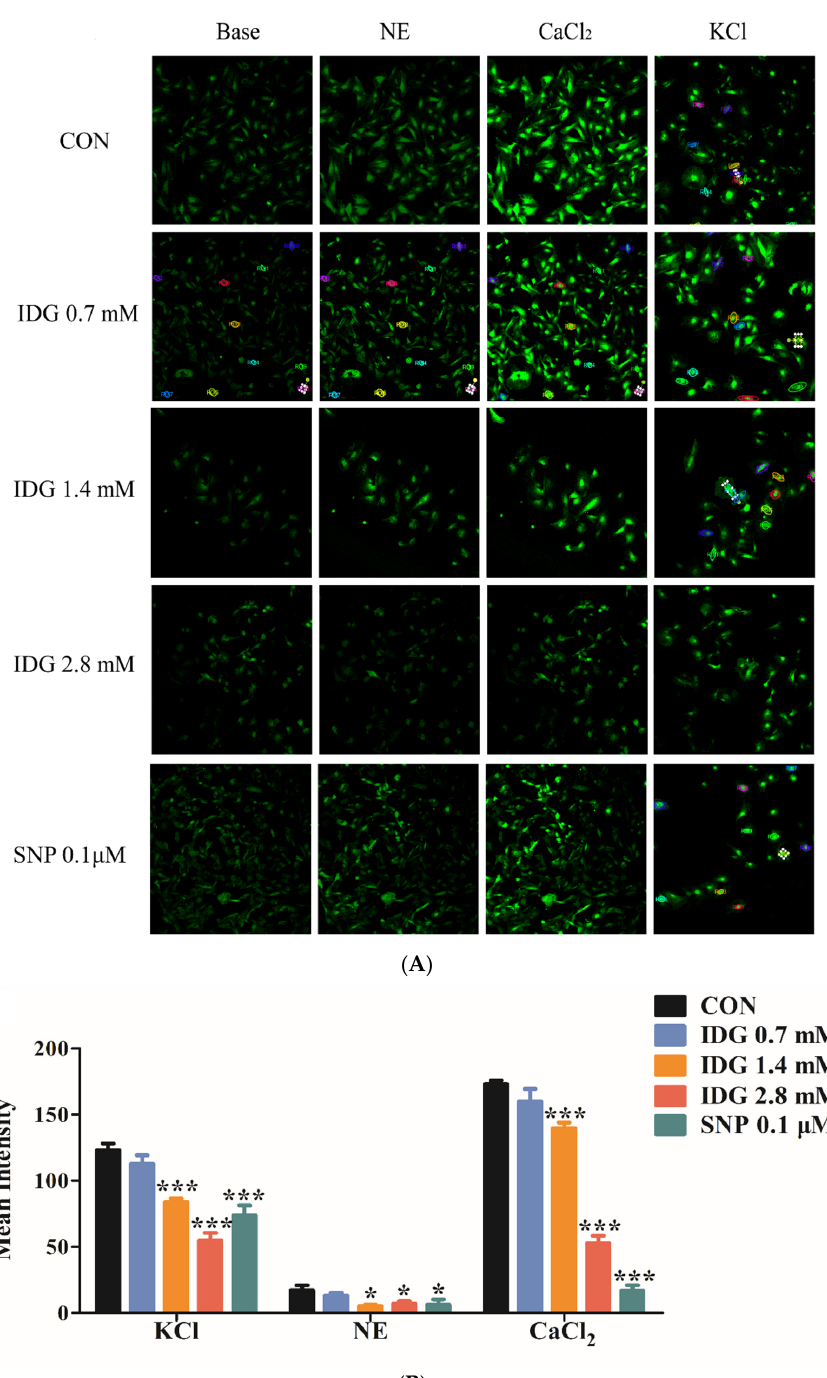
Figure 8. Relaxant effect of IDG (0.7, 1.4, and 2.8 mM) on vascular smooth muscle cells (VSMCs) contracted with NE (10 μ M) or KCl (100 mM). ( A ) The change in fluorescence intensities represent the change in [Ca 2+ ] in levels. Original fluorescence images (40×). ( B ) The effects of IDG (0.7, 1.4, and 2.8 mM) reduced the increase in intracellular fluorescence intensity in VSMCs due to KCl (100 mM) in Krebs solution, NE (10 μ M) in Ca 2+ -free Krebs solution, or the addition of CaCl 2 (2.5 mM) to provide Ca 2+ . Values are means ± SEM ( n = 6). Statistical analysis was performed using two-way ANOVA. Note: * p < 0.05, *** p < 0.001 compared with CON group.